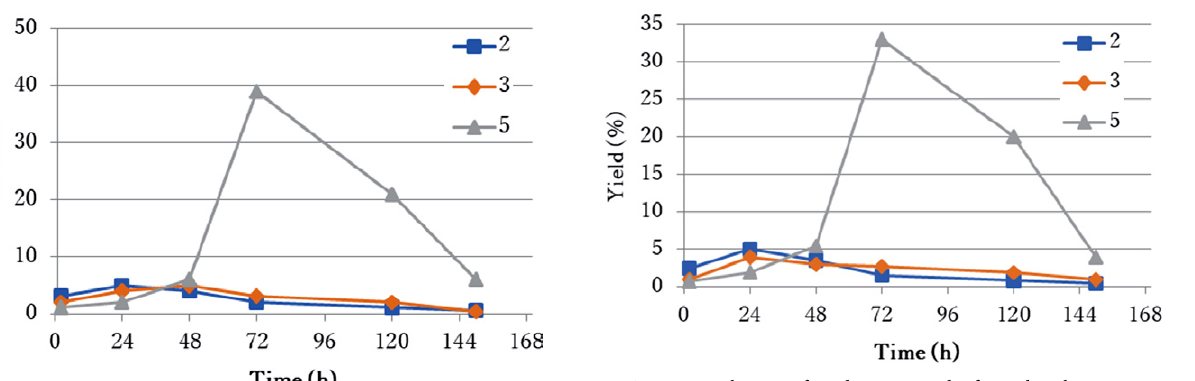
Figure 6. Evaluation of products 2 , 3 and 5 formed in the presence of synthetic silica Si syn.